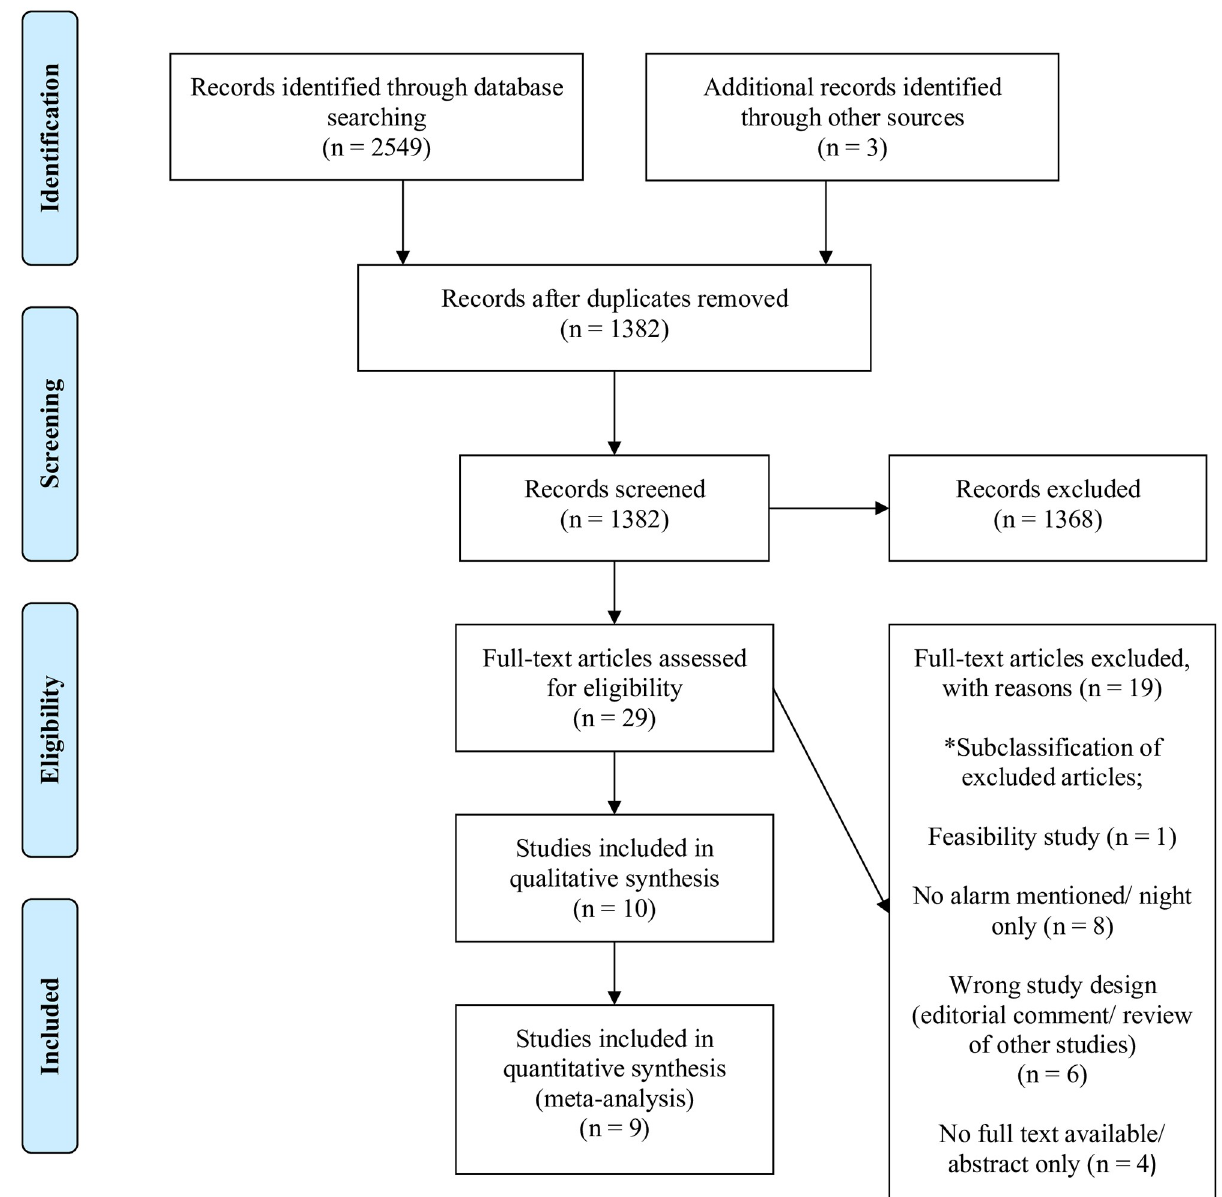
Fig 1. Flow diagram of the selection of eligible studies according to PRISMA guidelines.